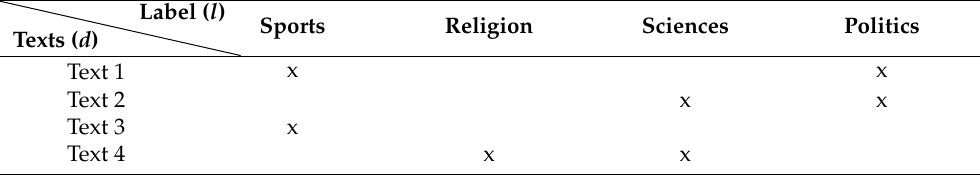
Table 1. Representation of a Set of multilabeled Examples. Label ( l ) Texts ( d )